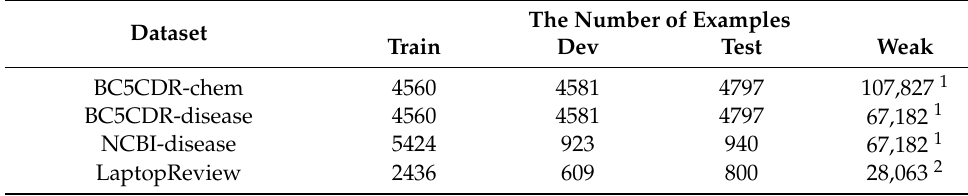
Table 1. The statistical results on experimental